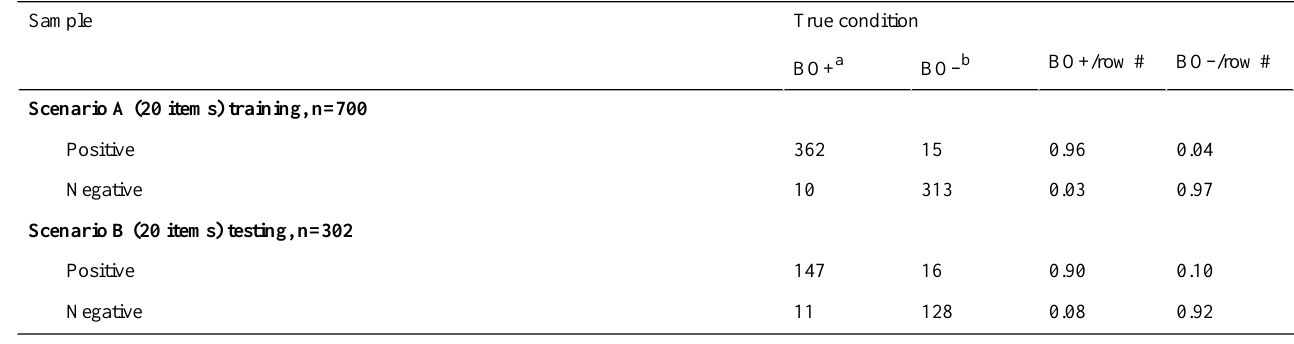
Table 3. Training and testing effects.